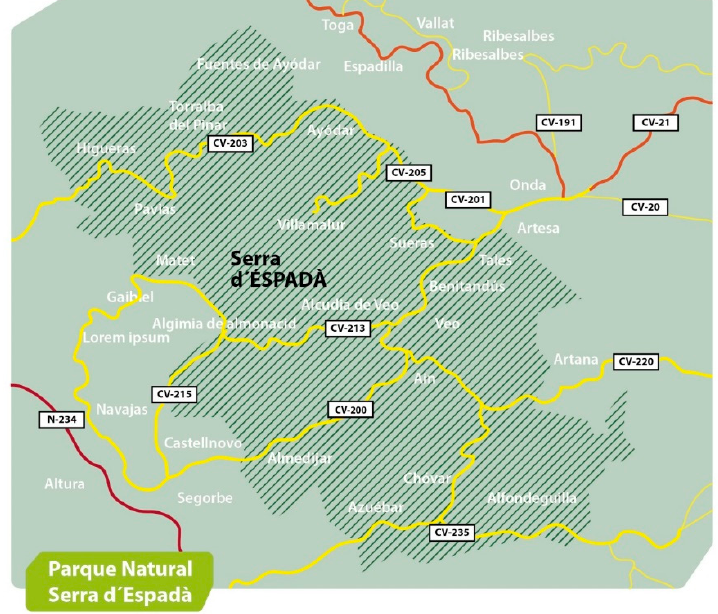
Figure 1. Map of the Sierra de Espadán Natural Park. In-house production.